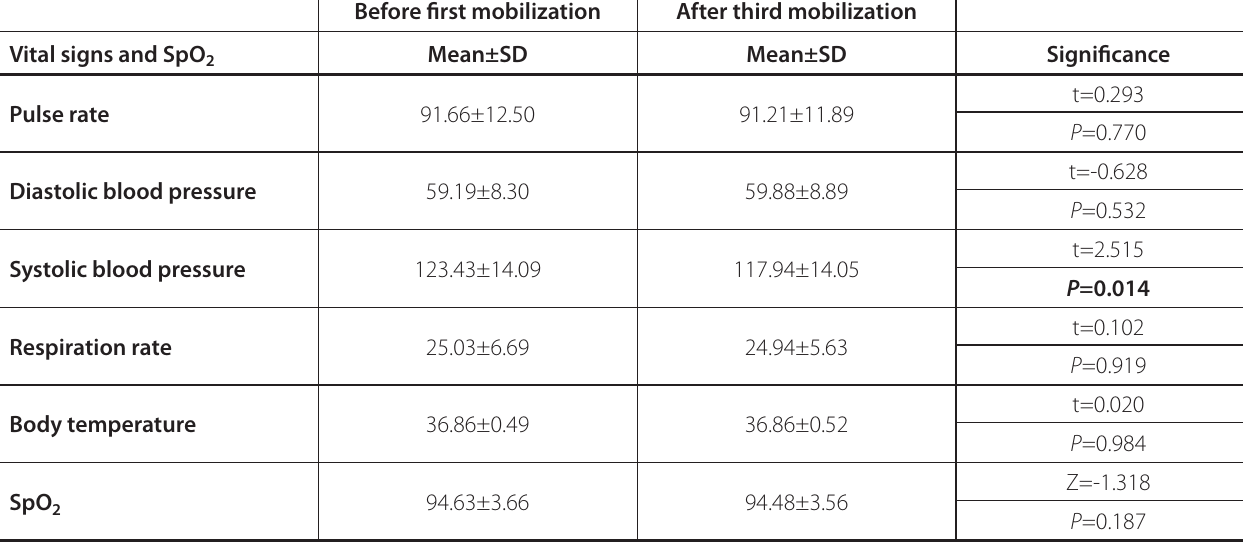
Table 5 . Comparison of vital signs and oxygen saturation of patients before the first mobilization and after the third mobilization (n=67). Before first mobilization After third